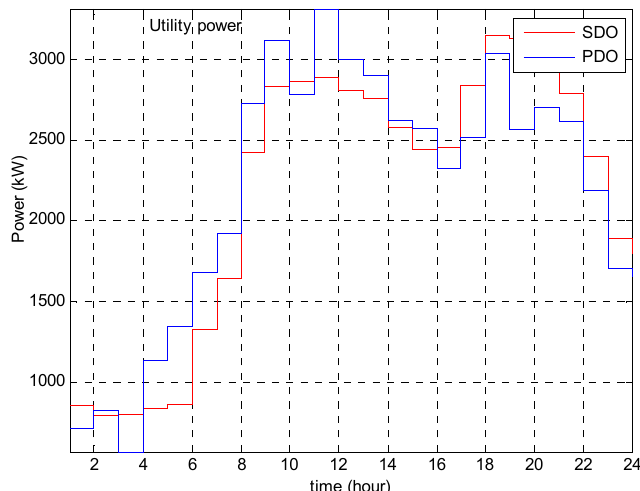
Figure 8. Utility power of the first day for PDO and SDO algorithms.